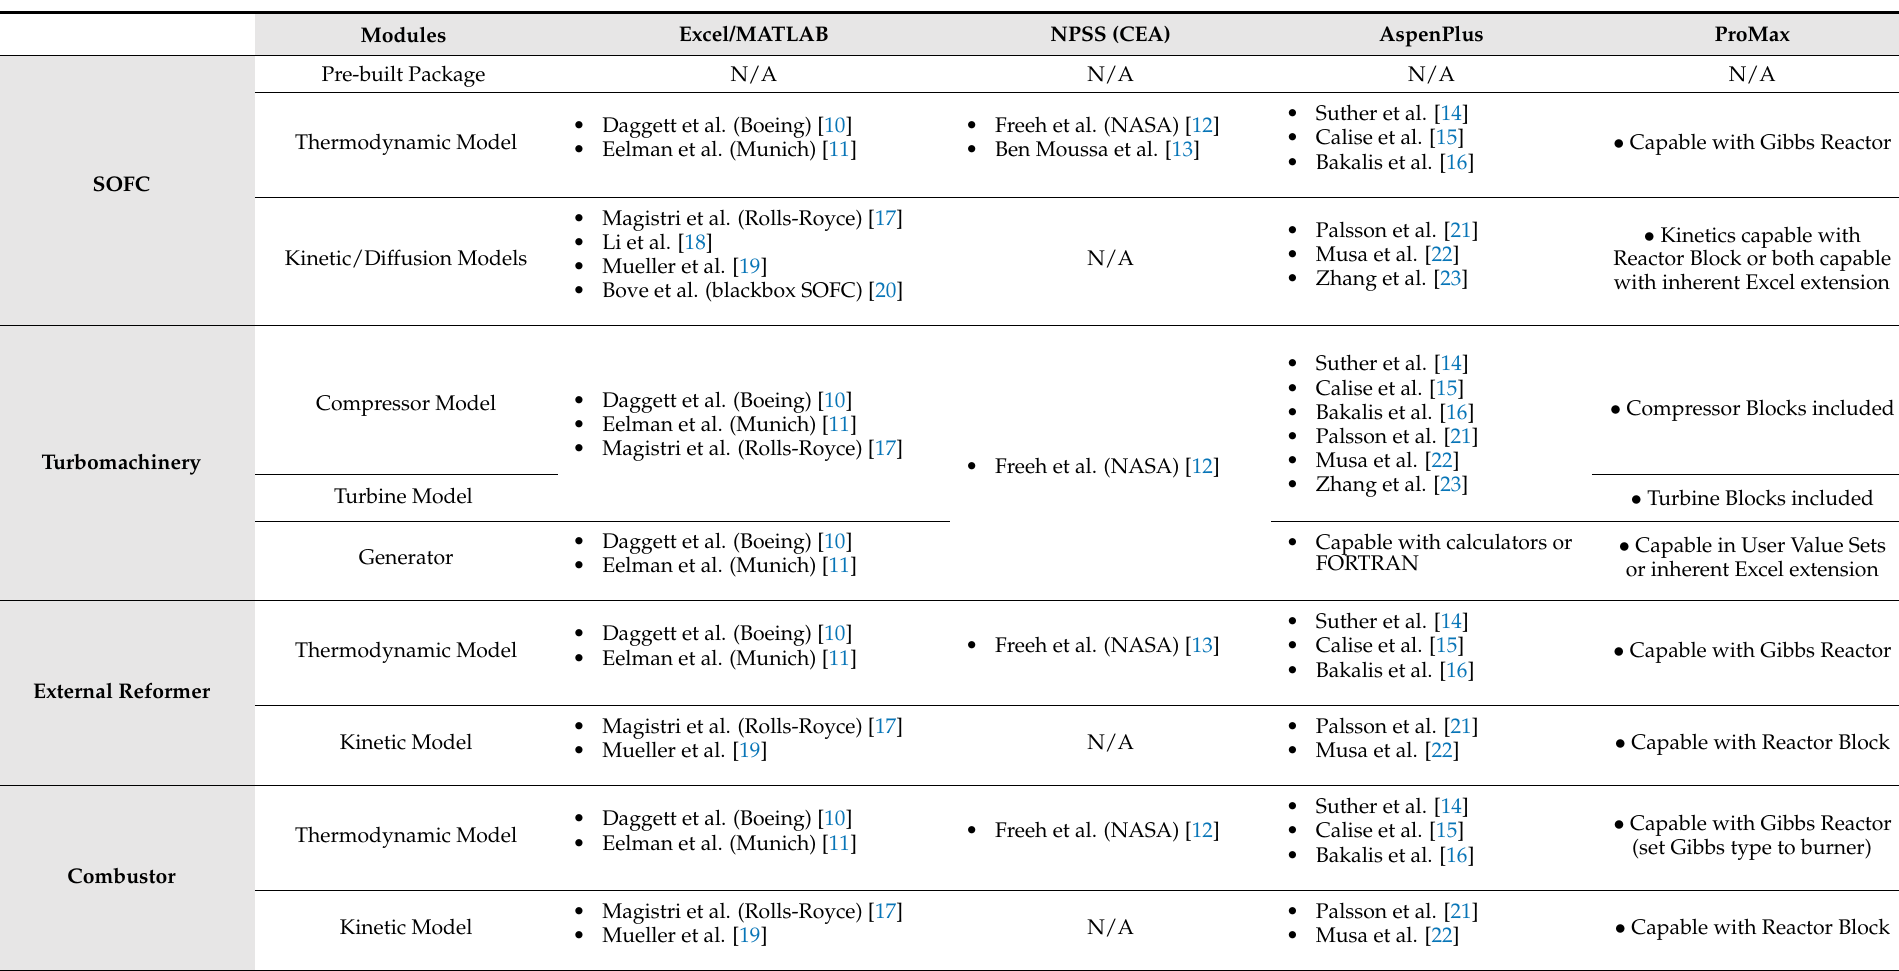
Table 1. Collection of system-level SOFC studies according to modeling